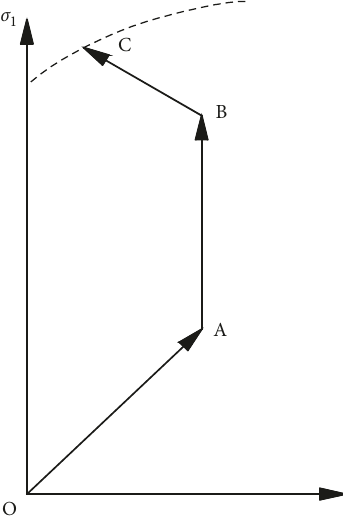
Figure 2: Stress path of unloading confining pressure.